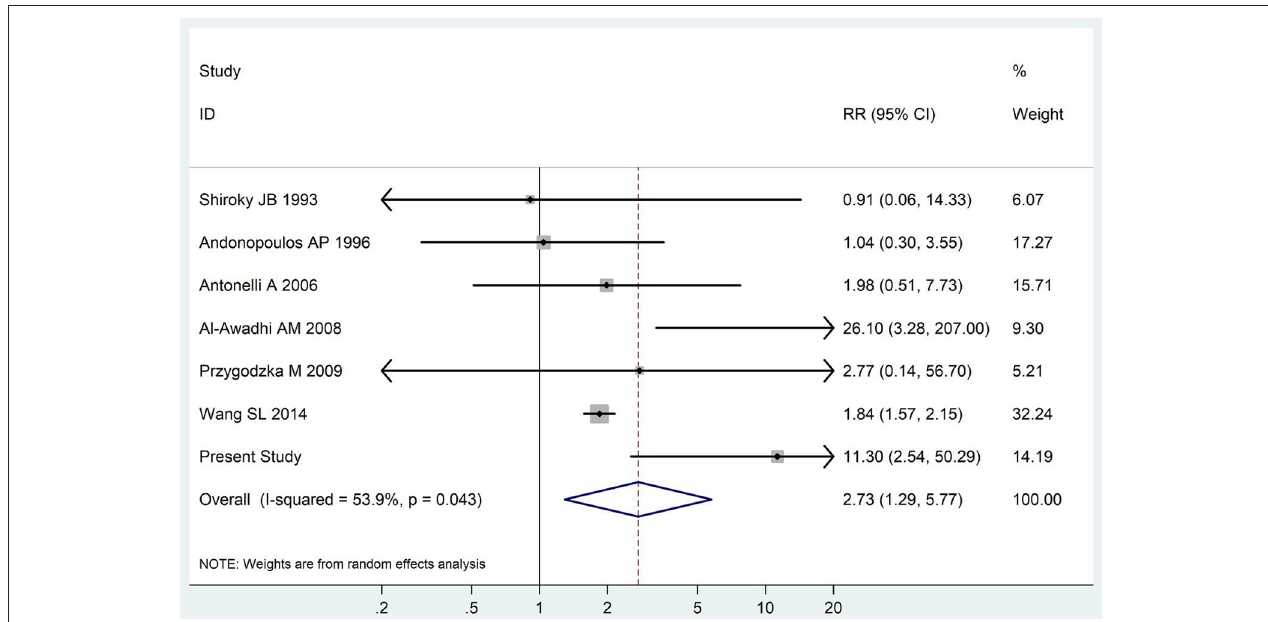
FIGURE 3 | Forest plot for the increased risk of hyperthyroidism among RA patients (The diamond represents the pooled RR and 95% CI).